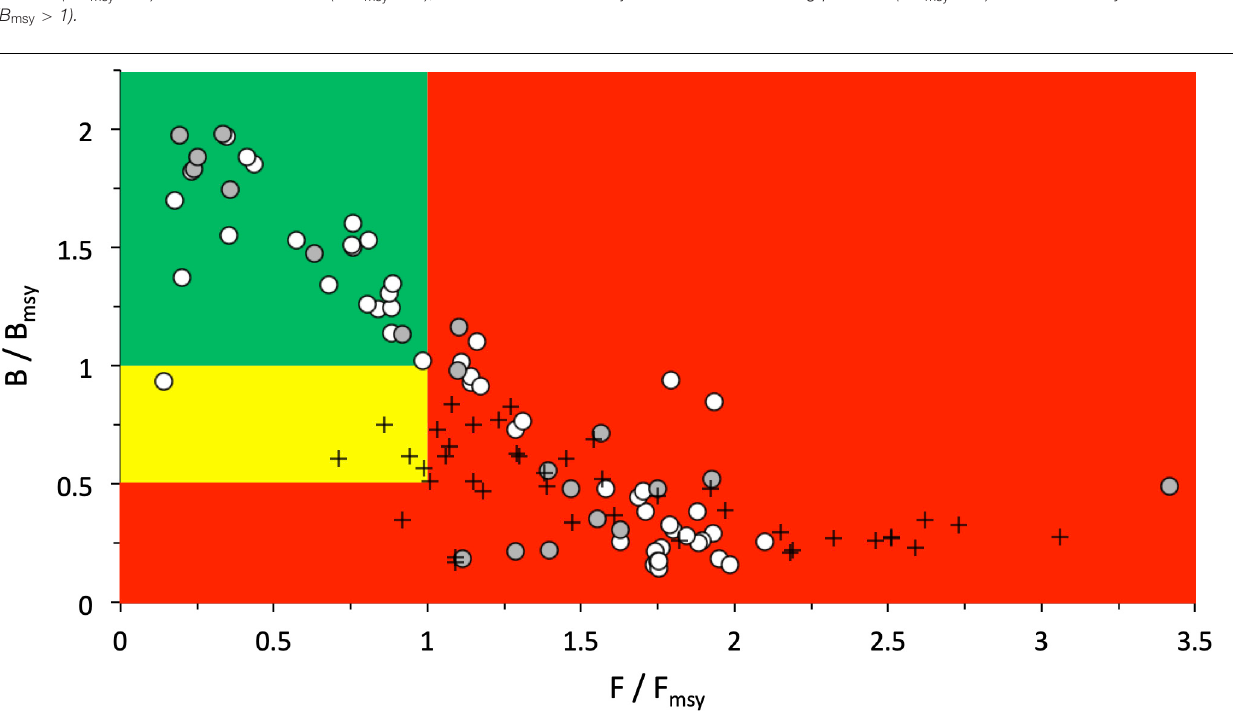
FIGURE 1 | The 74 un-assessed fish and invertebrate stocks of the Aegean Sea presented in a fishing pressure (F/F msy ) – stock status (B/B msy ) plot. White dots indicate by-catch and discarded stocks ( n = 54) and gray dots indicate alternatively targeted ones ( n = 20); black crosses refer to the previous assessment of commercial prime targets ( n = 42) using the CMSY method (Froese et al., 2018b). Red area, stocks that are being overfished or are outside of safe biological limits; Yellow area, recovering stocks; Green area, stocks subject to sustainable fishing pressure and of a healthy stock